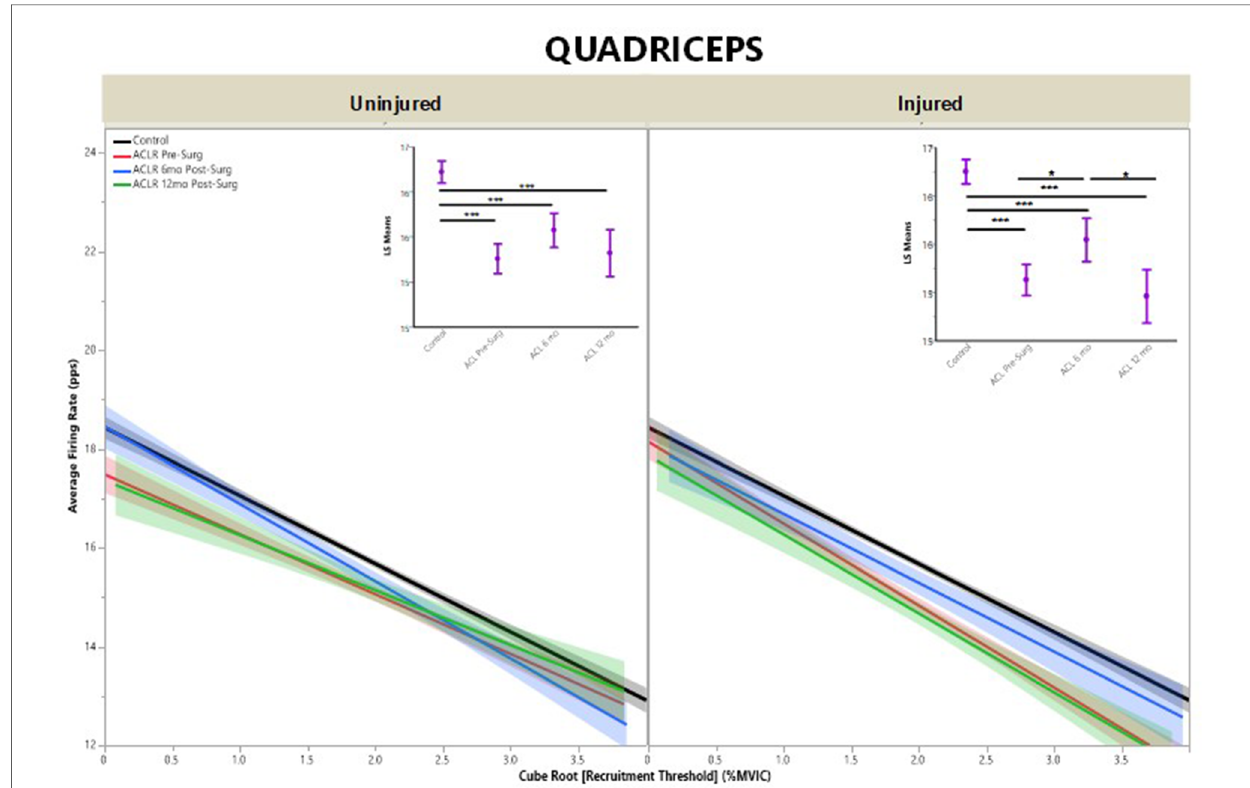
FIGURE 3 Quadriceps average fi ring rate by group for uninjured and injured limbs. Average fi ring rate represents motor unit fi ring frequency. ( Insets ) Least means square ANOVA demonstrates signi fi cant differences of MUAP between groups. (* denotes p <0.05; *** denotes p <0.001; line shading and error bars denote 95% con fi dence intervals of the